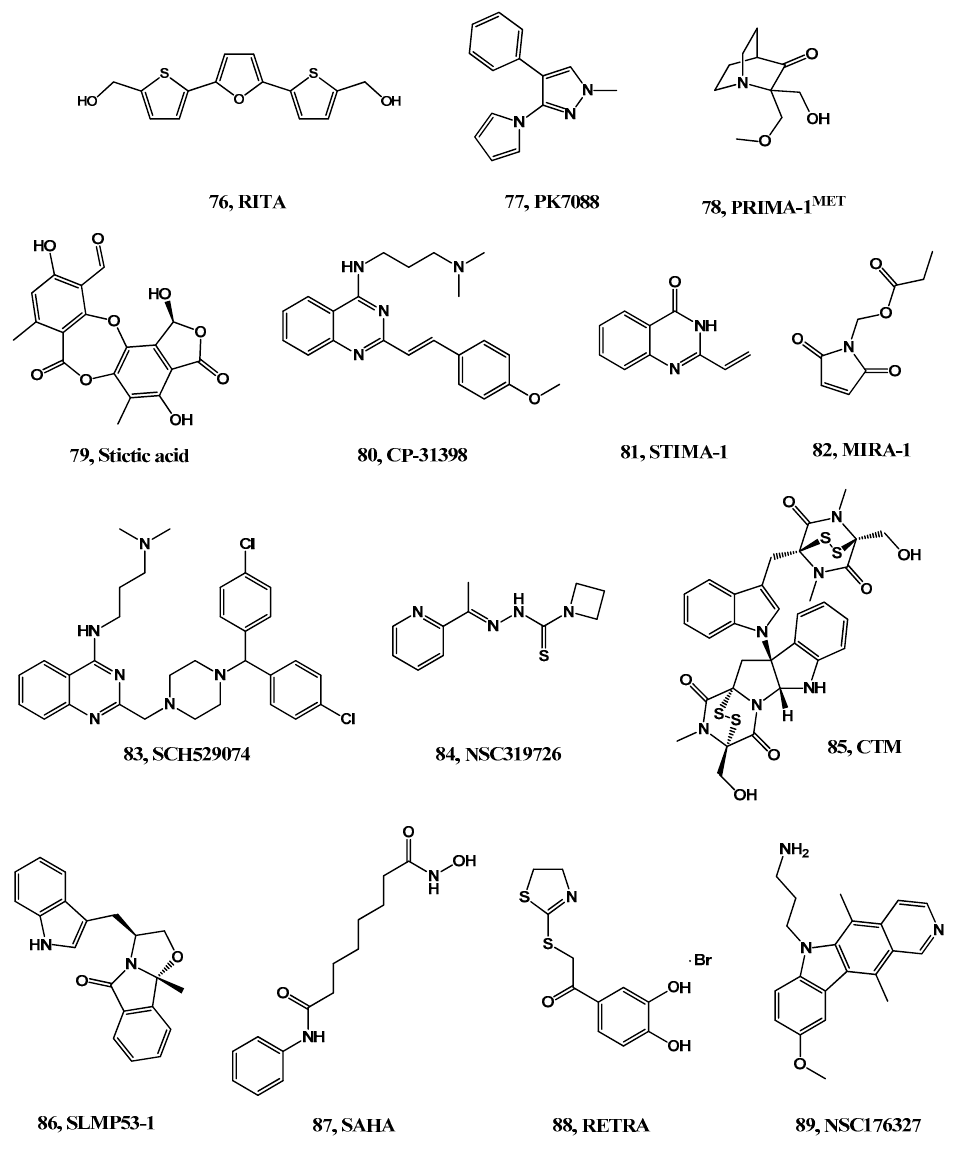
Figure 17. Compounds targeting mutant p53.